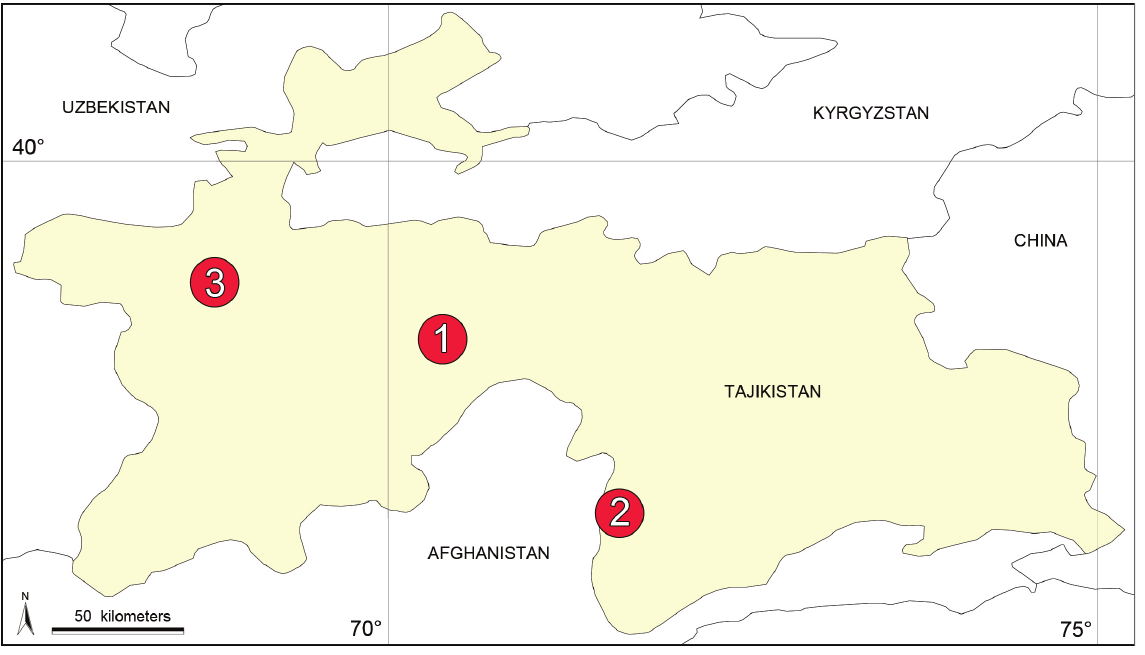
Fig. 7. New distribution records of Pholcus species from Tajikistan. ① Pholcus saidovi Yao & Li sp. nov. ② P. shuguanensis Yao & Li sp. nov. ③ P. sidorenkoi